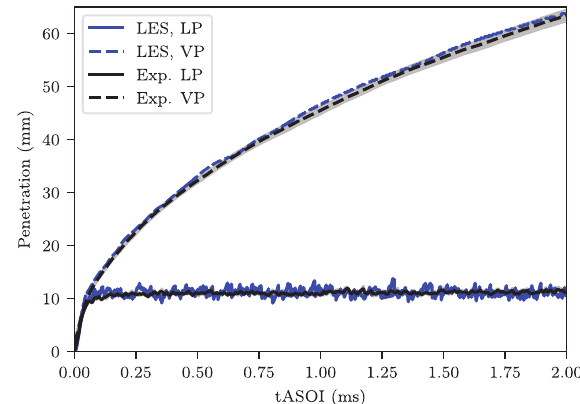
Fig. 5. Temporal evolution of vapor penetration VP (dashed lines) and liquid penetration LP (solid lines) for the ECN Spray A under non-reactive conditions from the LES (blue curves) and experiments obtained by Schlieren measurements [52] and Mie scattering [52] (black curves). The experimental standard deviation is marked by gray